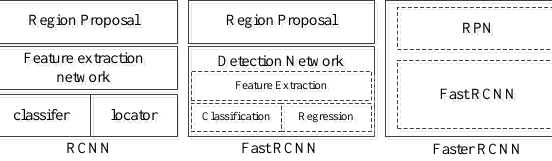
Figure 2. Framework of machine Learning based object detection